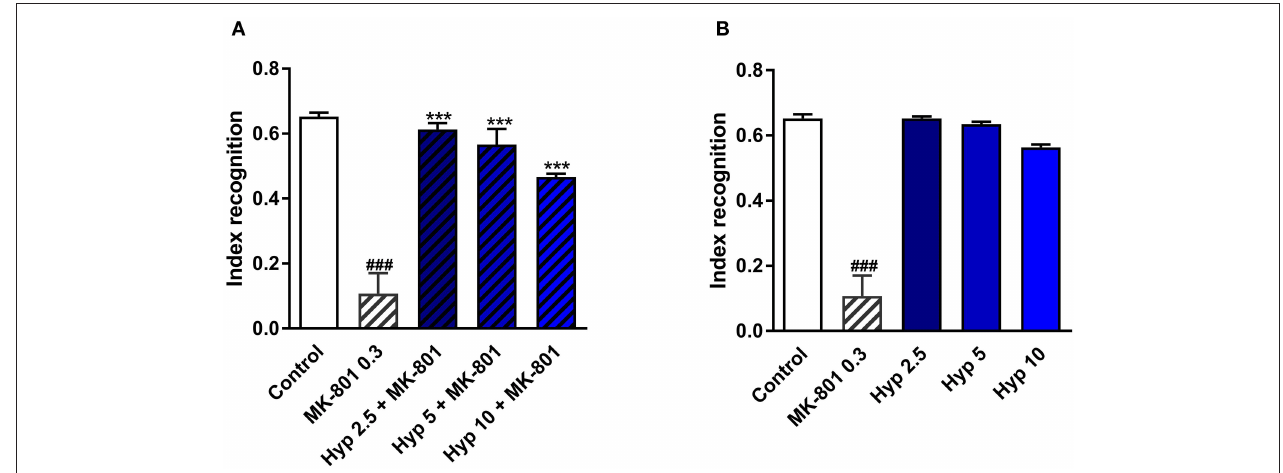
FIGURE 3 | The effect of pretreatment with glutamate system modulator on hyperforin activity in the NOR in mice. (A,B) Hyperforin (2.5, 5, 10 mg/kg; i.p. ) was administered 60min before the first session. MK-801 (0.3 mg/kg; i.p. ) was administered 30min before the first training session of the NOR test. ### p < 0.001 vs. control, *** p < 0.001 vs. MK-801, n = 6–8; [ A : F (4,32) = 70.04; p = 0.0001], [ B : F (4,30) = 36.08; p = 0.0001]. All data was analyzed by one-way ANOVA and Newman-Keuls multiple comparisons test. All values are expressed as mean ± S.E.M.